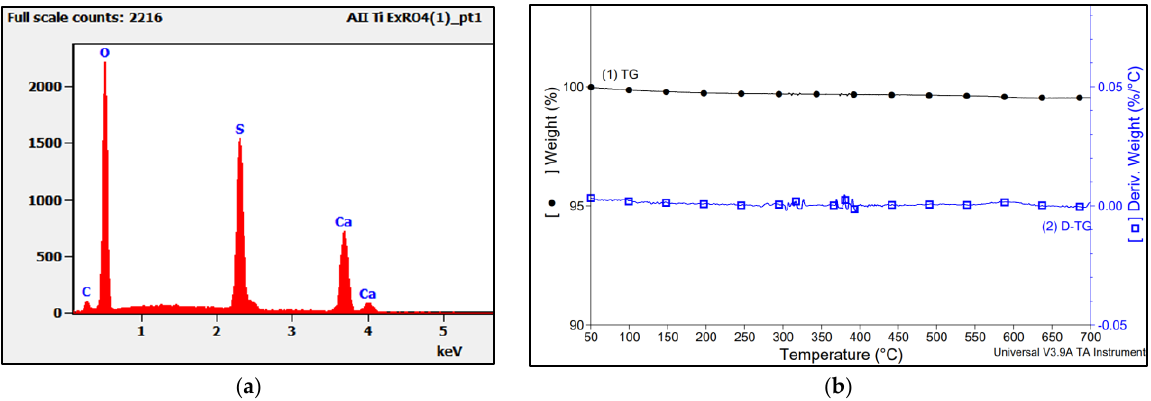
Figure 3. ( a,b ) Characterization of AII filler: ( a ) EDX spectra and ( b ) TGA (under N 2 , 20 °C/min).